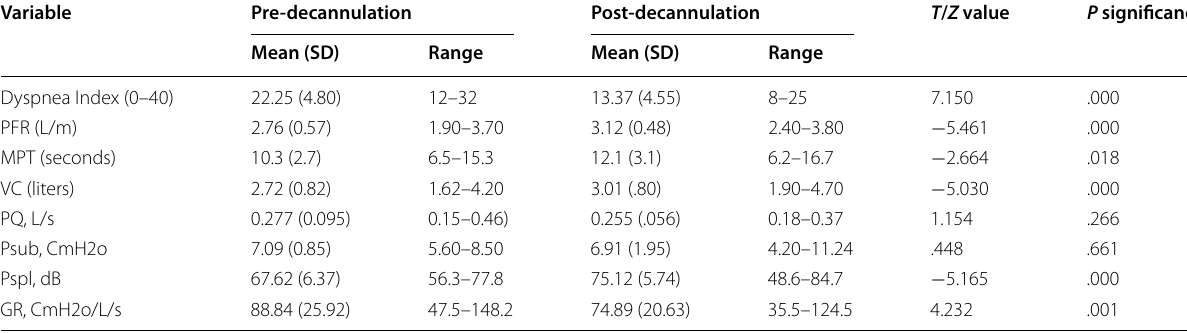
Table 1 The differences in the outcome measures before and after